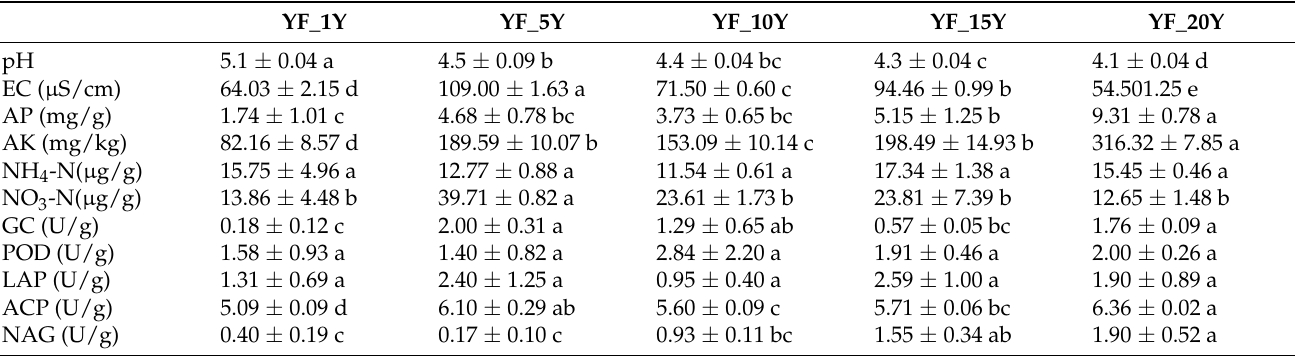
Table 1. Soil physiochemical